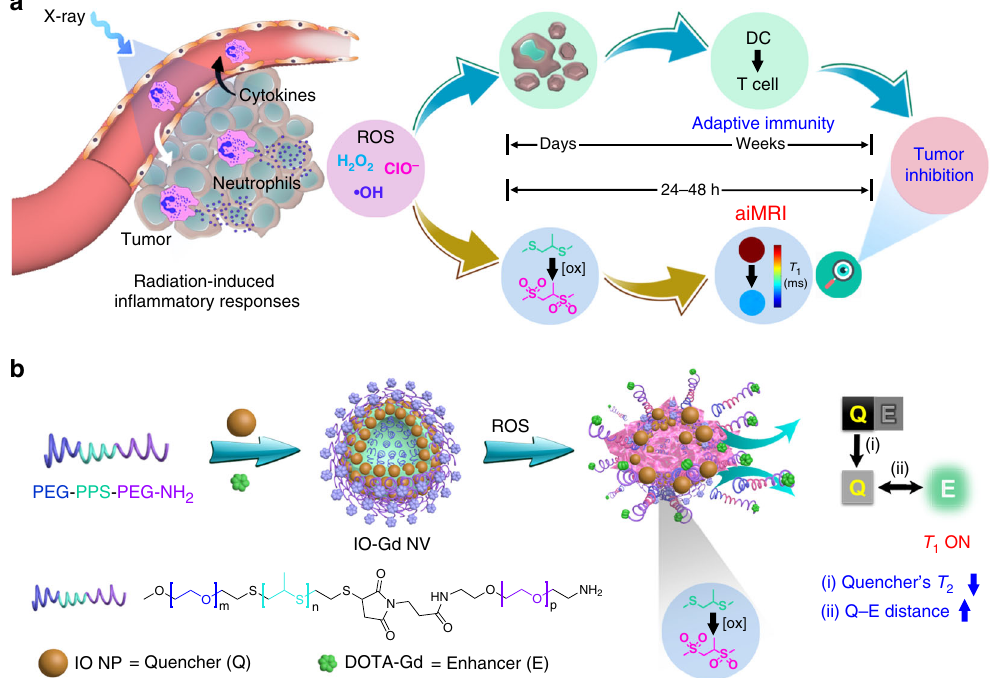
Fig. 1 Illustration of the activatable in fl ammation magnetic resonance imaging (aiMRI). a Radiotherapy (RT)-induced acute in fl ammatory response leads to reactive oxygen species (ROS) production, which exerts tumor inhibition through ROS-induced cell apoptosis and T-cell activation pathways. The adaptive immune responses usually take days to weeks after RT. The aiMRI is applied to quantify the ROS at an early time (24 – 48 h) after RT which is proposed to stratify the tumor inhibition. b The procedure of self-assembly and disassembly of the aiMRI nanoprobe that is composed of iron oxide nanoparticles (IO NPs), gadolinium (Gd) species, and triblock PEG-PPS-PEG-NH 2 polymers, denoted as IO-Gd NVs. The oxidation of hydrophobic thioethers to hydrophilic sulfones leads to swelling of the polymers and decomposition of the IO-Gd NVs. This procedure confers dual-positive factors to the T 1 MRI OFF – ON effect: the quencher ’ s T 2 effect is decreased upon disassembly due to the dispersed magnetic fi eld coupling effect; (ii) the quencher- enhancer (Q-E) distance is increased due to the oxidation-induced swelling of polymers equipped with Gd